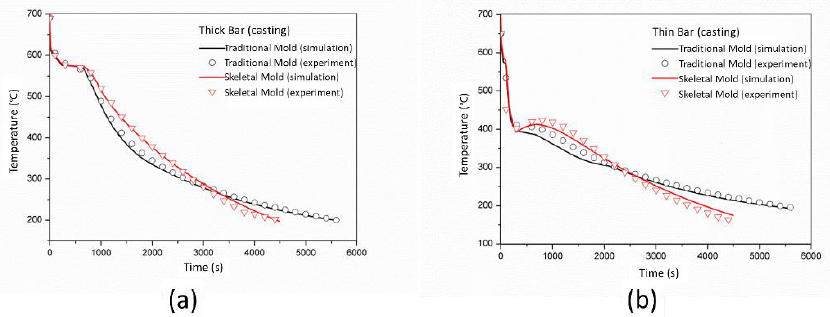
Figure 28. Comparison of the simulated and experimental cooling curves of thick ( a ) and thin ( b ) bars of the specimen